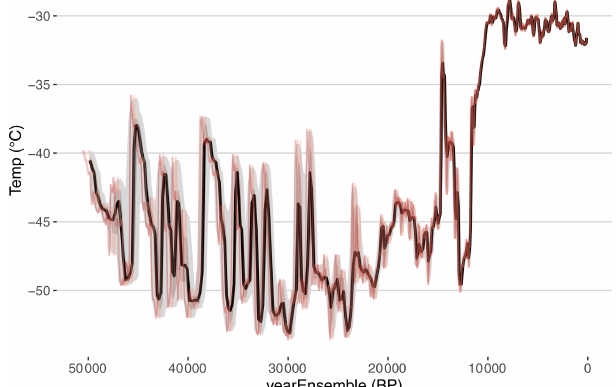
Figure 3. Impact of age uncertainty on reconstructed temperature at GISP2 over the past 50000 years. The median ensemble member is shown in black, with the 50% and 95% highest-density probability ranges shown in dark and light gray, respectively. Five random age- uncertain temperature ensemble members are shown in